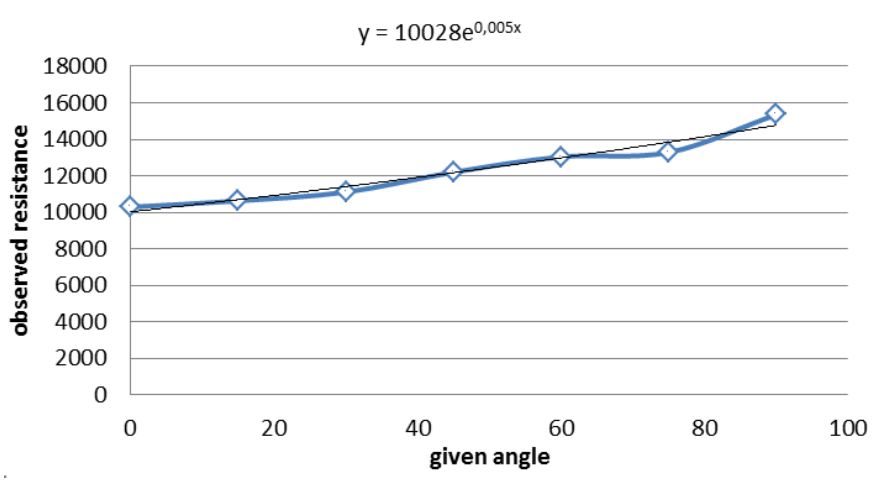
Figure 10. Resistance depending on the angle.